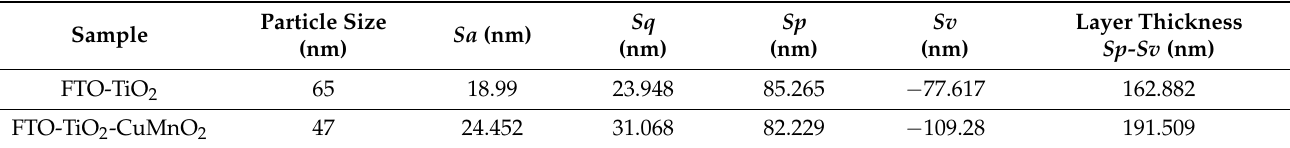
Table 1. Surface particle size, nano-roughness and layer